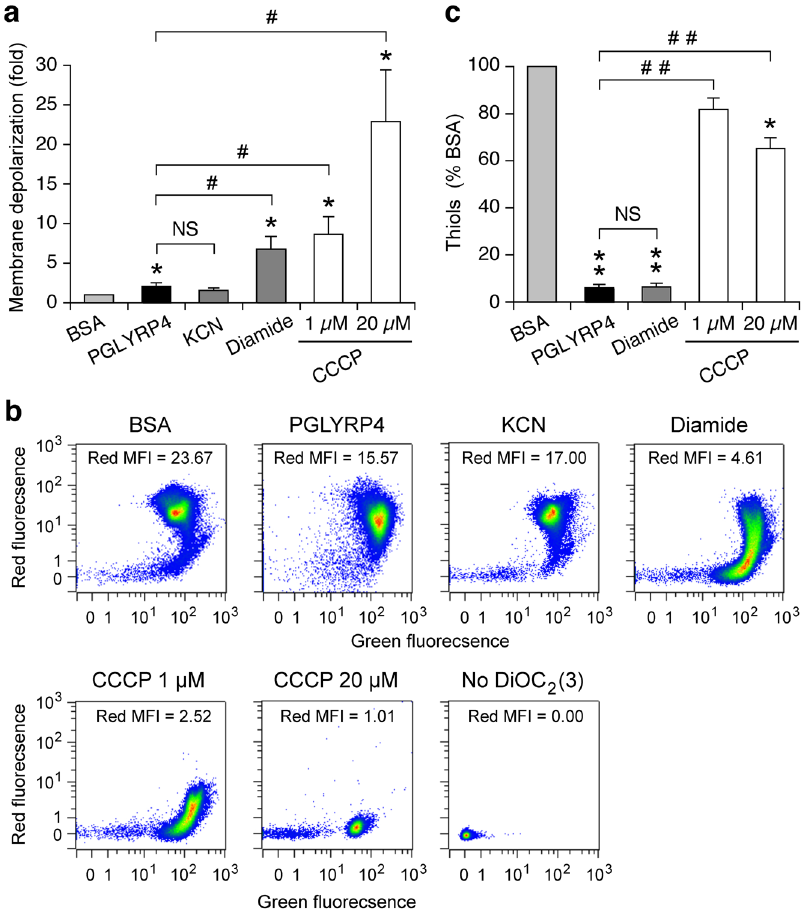
Figure 10. Comparison of membrane depolarization and thiol depletion in E. coli . E. coli MG1655 were treated with BSA, PGLYRP4, KCN, diamide, or CCCP as indicated for 30 min. ( a ) Membrane depolarization was measured by flow cytometry with membrane potential sensitive dye DiOC 2 (3) and the results are the ratios of mean red fluorescence intensity in BSA/treated cells. ( b ) Representative dot plots with mean fluorescence intensities (MIF). ( c ) The amounts of thiols expressed as percent of control with BSA (100%). Means ± SEM from 6 ( a ) or 4 ( c ) experiments (biological replicates); * P < 0.05, ** P < 0.001, PGLYRP4, KCN, diamide, or CCCP vs BSA; NS not significant ( P > 0.05); # P < 0.05, ## P < 0.001 as indicated by